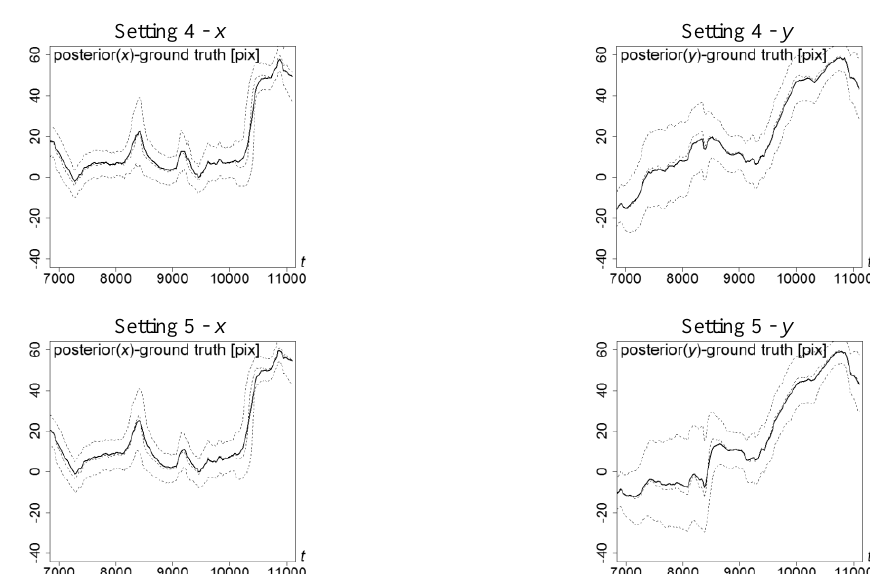
Figure 5. Posterior distributions of parameter c in each setting